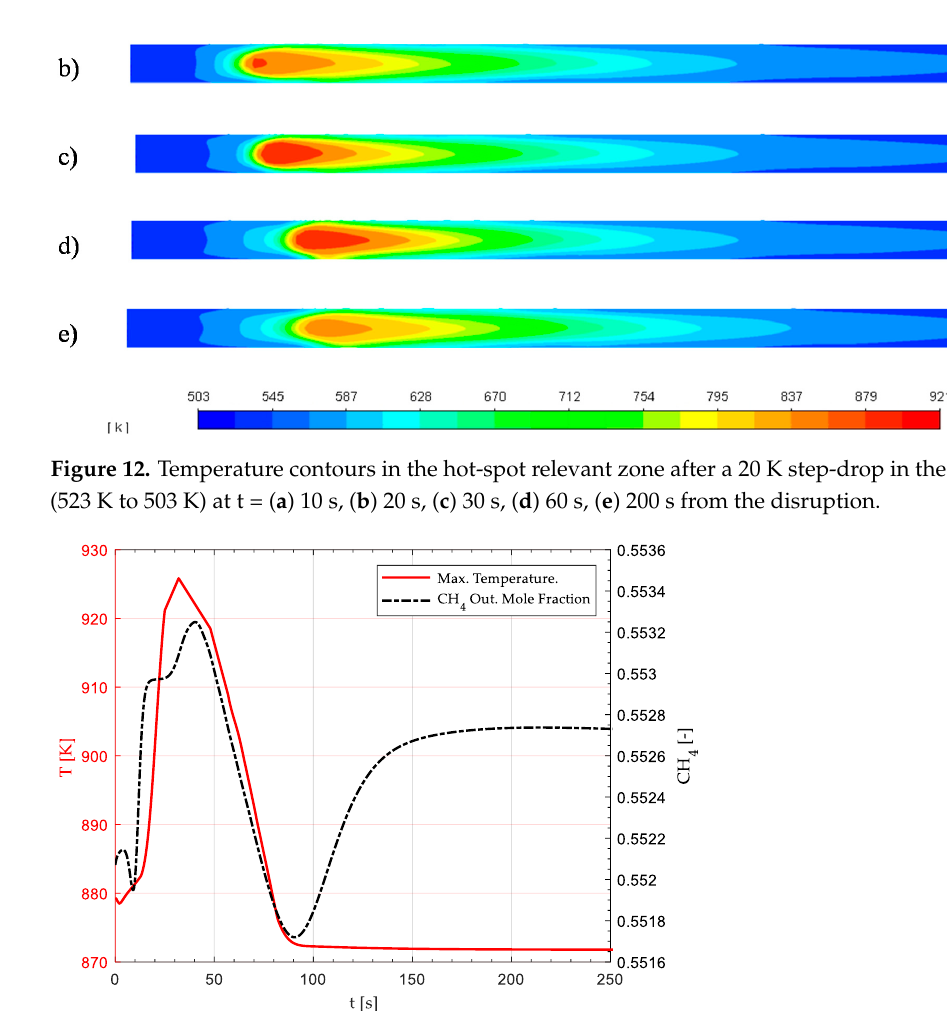
Figure 14. CO 2 mole fraction contours in the hot-spot (First 250 mm of reactor tube length) after a 20 K step-drop in the feed gas (523 K to 503 K) at t = ( a ) 10 s, ( b ) 20 s, ( c ) 40 s from disruption. The concentration front successively moves downwards due to lower reaction rates near the inlet. A maximum concentration gradient is observed in c), which coincides with the maximum temperature in Figure 12a.